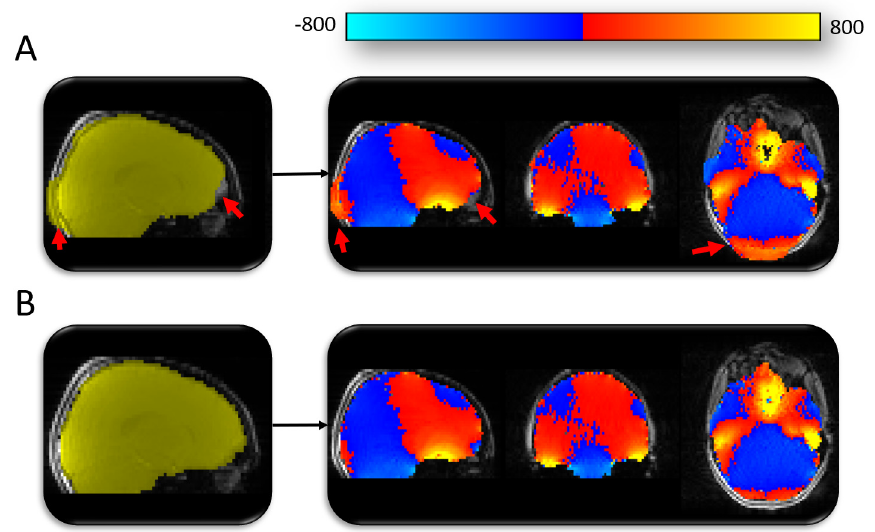
Figure 3. Manual editing of masks for creating fieldmaps. ( A ) Automated mask generated using BET (shown in yellow). The automated methods used to mask the fieldmap magnitude image were producing sub-optimal results (highlighted by red arrows). Fieldmap image (blue-red-yellow image) generated using the sub-optimal mask would leave distortion-susceptible brain regions without appropriate distortion correction (e.g. red arrow in frontal lobe region). ( B ) Mask following manual editing (yellow) and the subsequent fieldmap (blue- red-yellow) with appropriate coverage of distortion-susceptible regions.